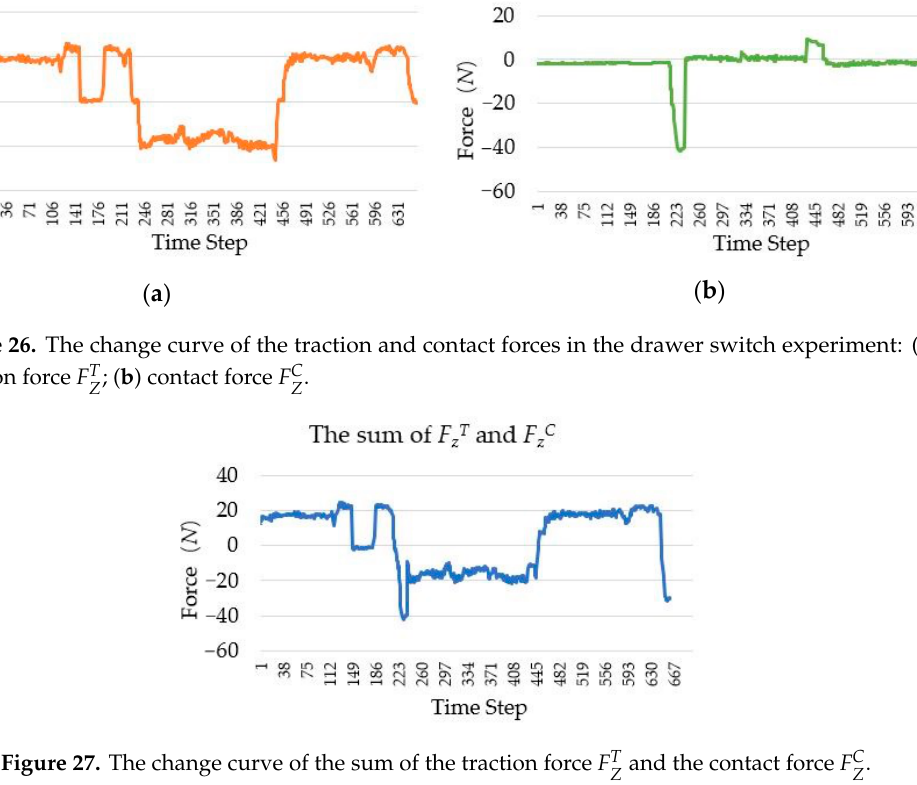
Figure 27. The change curve of the sum of the traction force 𝐹 (cid:3027)(cid:3021) and the contact force 𝐹 (cid:3027)(cid:3004) .